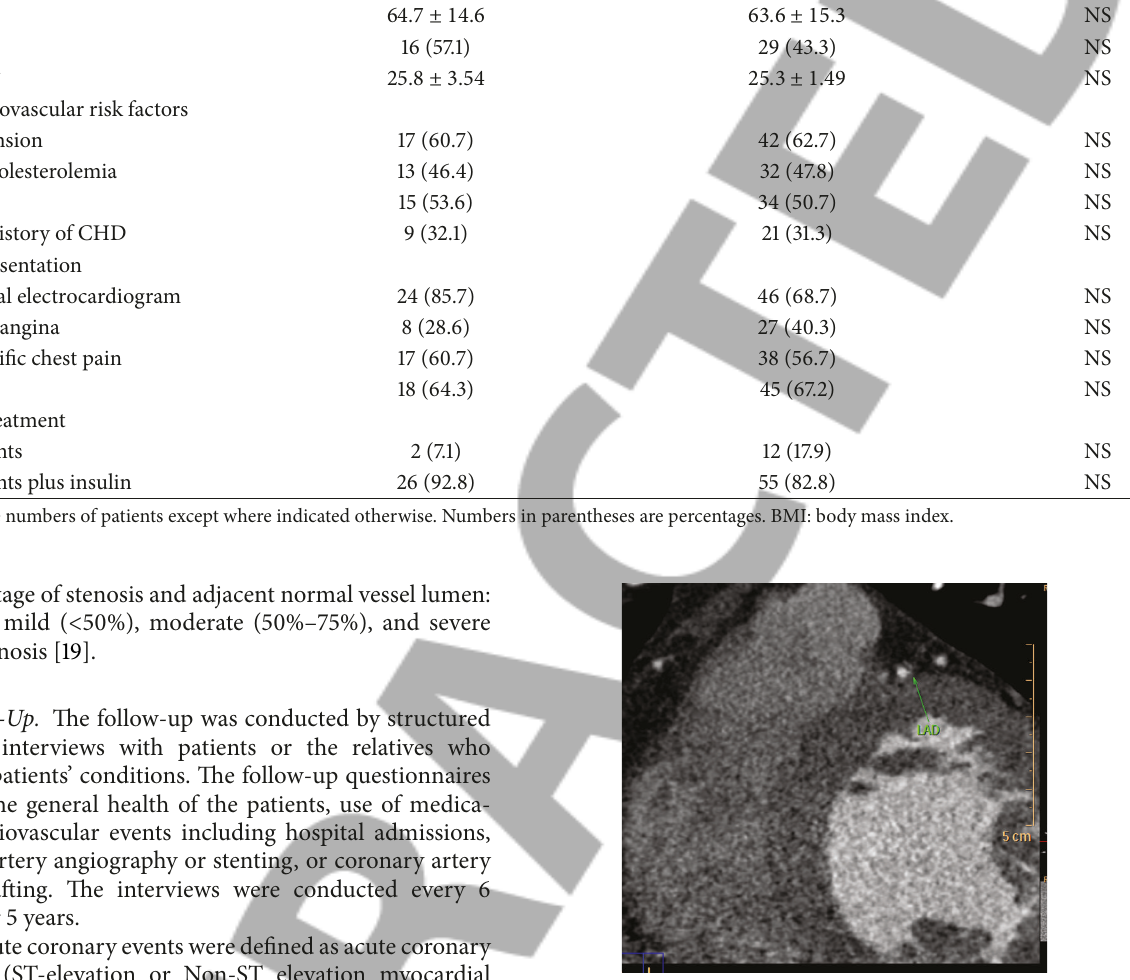
Figure 2: A 51-year-old female with an 8-year history of type 2 diabetes. Soft plaques were identified intheleft descending coronary artery with an eccentric and unsmooth surface (black arrow). CT value was 28